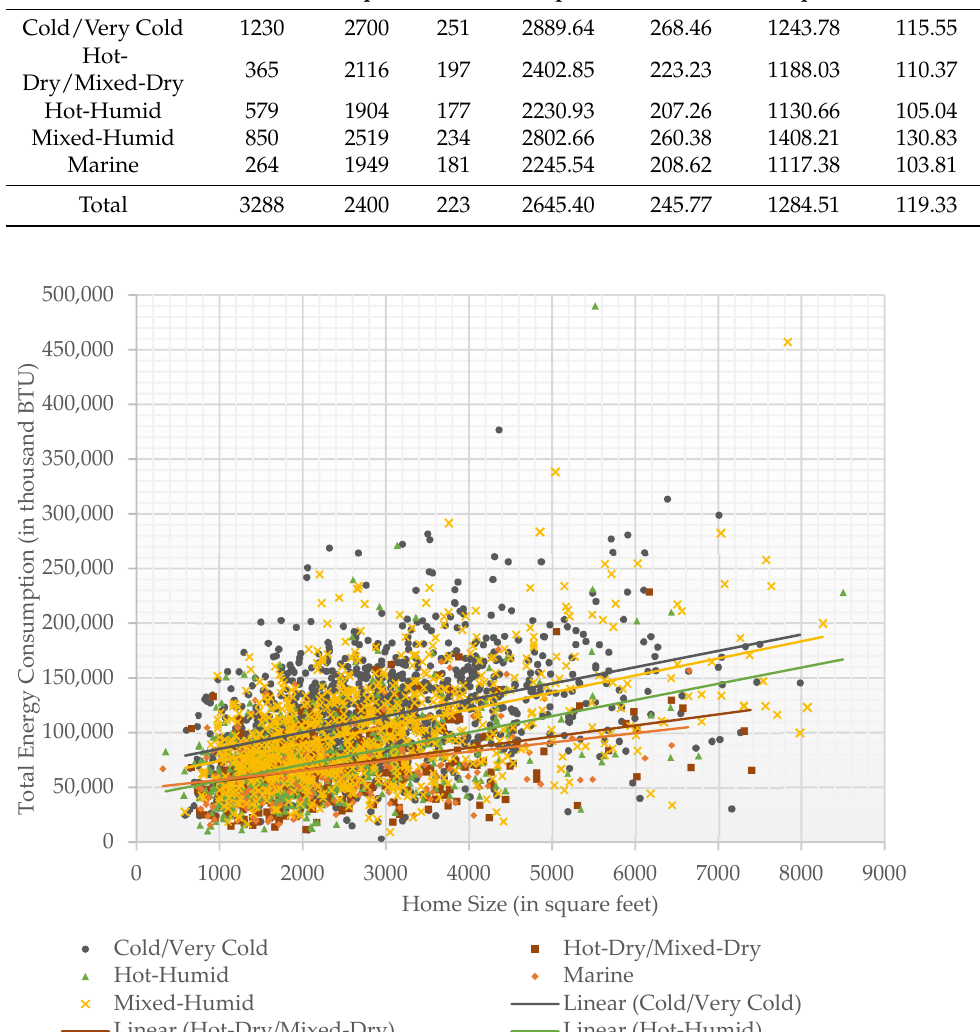
Table 1. Total square footage (sqft) and square meters (m 2 ) of home per climate zones (total n = 3288).